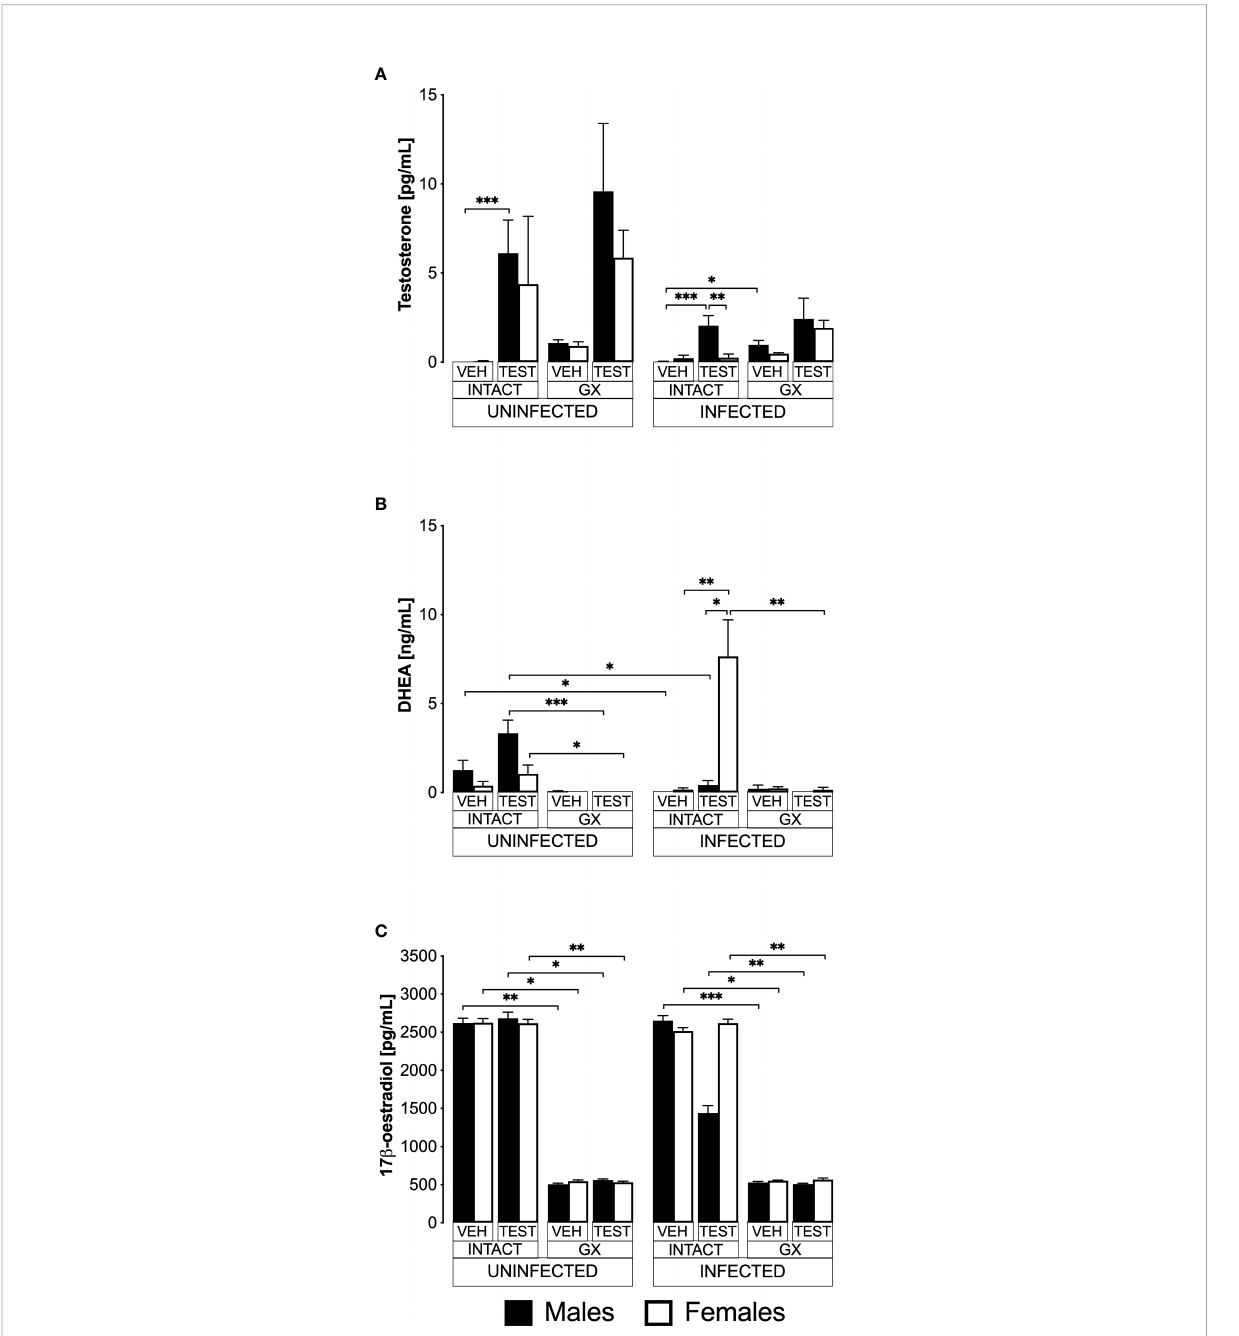
FIGURE 1 Testosterone generated a dimorphic pattern of free testosterone and dehydroepiandrosterone (DHEA) levels in intact CBA/Ca mice infected with Plasmodium berghei ANKA. Eight groups of males and eight groups of females were analysed. Four groups of each sex were gonadectomised (GX), and the other four groups were left intact. Four weeks later, two intact and two GX groups of each sex received testosterone for three weeks, and the other two groups received vehicle. In addition, one intact and one GX group treated with testosterone and one intact and one GX group treated with the vehicle of each sex were infected with P. berghei ANKA. Finally, the remaining groups were injected with PBS for infection control. All mice were sacri fi ced on day eight post-infection, blood was collected in heparinised tubes, centrifuged, and plasma was frozen until use. Sex steroids were extracted from the plasma with ethyl ether and hydrated with PBS/gelatine. Free testosterone concentration (sensitivity: 0.04 pg) is shown in (A) , DHEA concentration (sensitivity: 0.07 ng) in (B) , and 17 b -oestradiol concentration (sensitivity: 15 pg) in (C) . Each bar represents the mean ± SEM of the following groups: the vehicle-treated (VEH), the testosterone-treated (TEST), the intact (INTACT), or the gonadectomised (GX). Mice infected with P. berghei ANKA (INFECTED) or uninfected (UNINFECTED). Asterisks represent statistically signi fi cant differences between groups (*) p<0.05; (**) p<0.01; (***) p<0.001; calculated by Kruskal-Wallis analysis with Dunn ’ s post-hoc test. The whole experiment was performed twice (n =